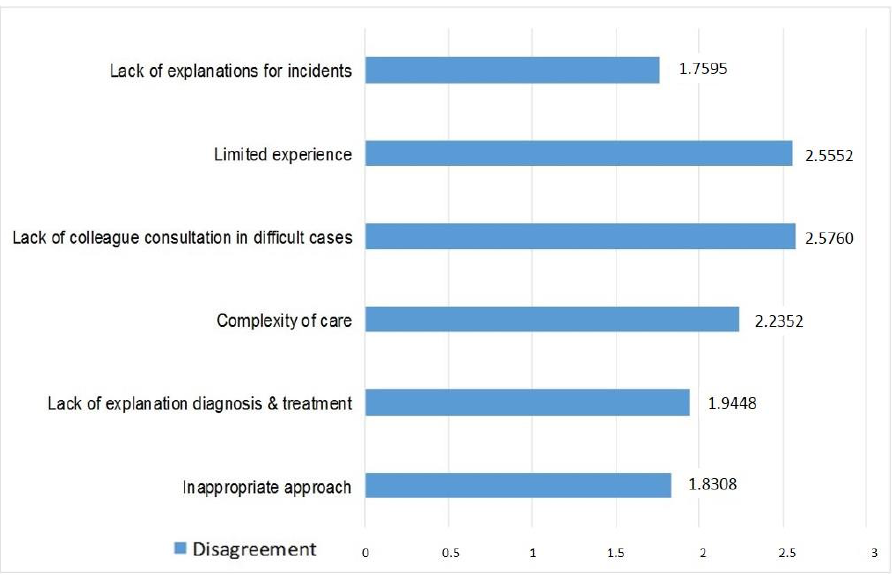
Figure 2. Factors that predispose physicians to complaints.